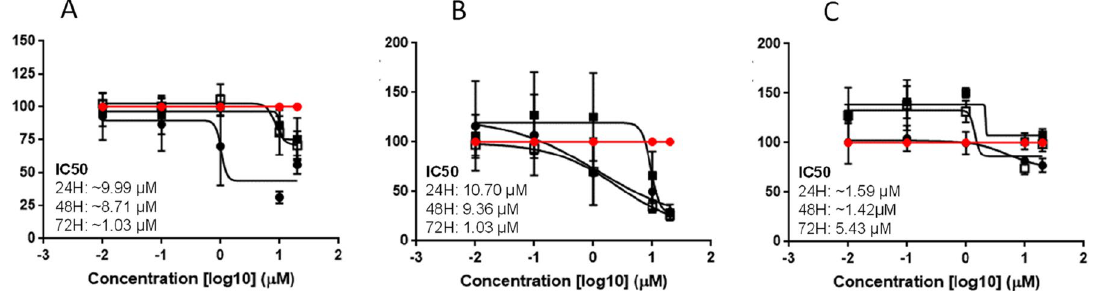
Figure 6. ( A–C ) Dose–response curve of ICT2700 treatment of FaDu-RPMI ( A ), FaDu-CAF002 ( B ) and FaDu-CAF003 ( C ) conditioned media viability for time-point 24, 48 and 72 h using Alamar Blue viability assay. Vehicle control was DMSO at 1%